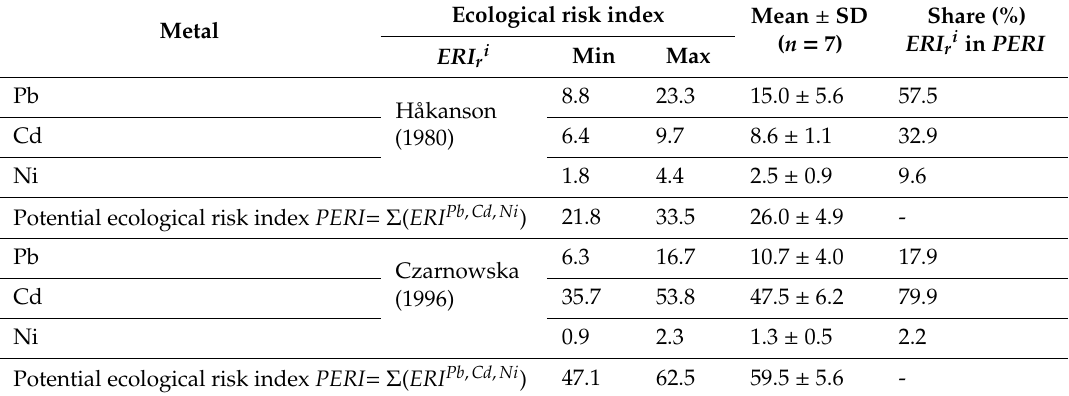
Table 8. Ecological risk index ( ERI ri ) and PERI for the particular heavy metals at the whole NP (7 sites, Figure 1).